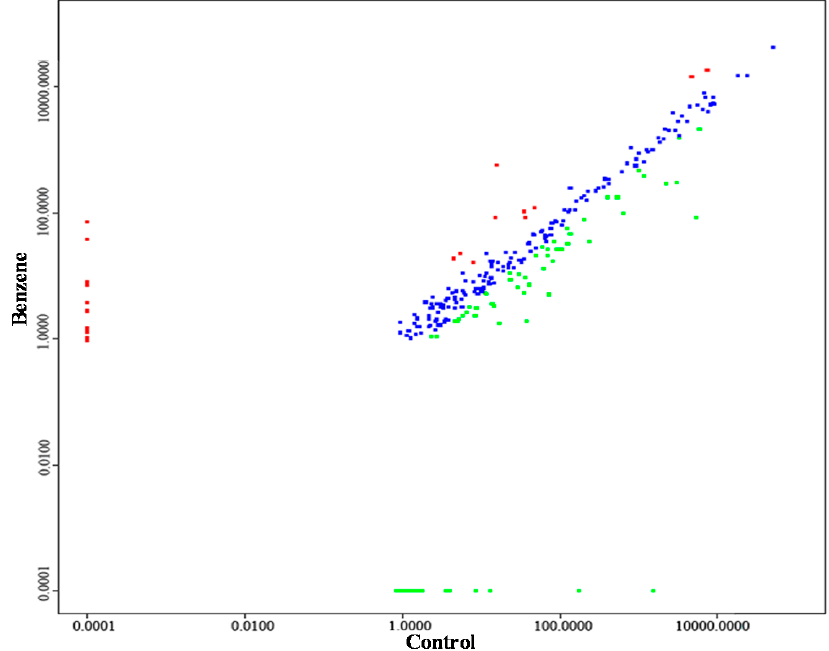
Figure 2. Scatterplot showing the relationship between the benzene exposure group and the control group. Red dots indicate the 2-fold upregulated miRNAs and green dots indicate the 2-fold downregulated miRNAs compared with the control group. Blue dots indicate no differences between two groups. n = 3 for each group. Table 4. Aberrant miRNAs profile of Lin − cells expressed between benzene exposure group and the control group.